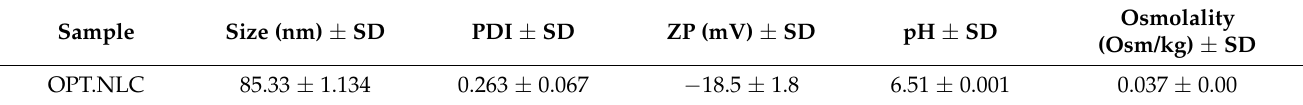
Table 4. Chemical and physical characterization of optimized